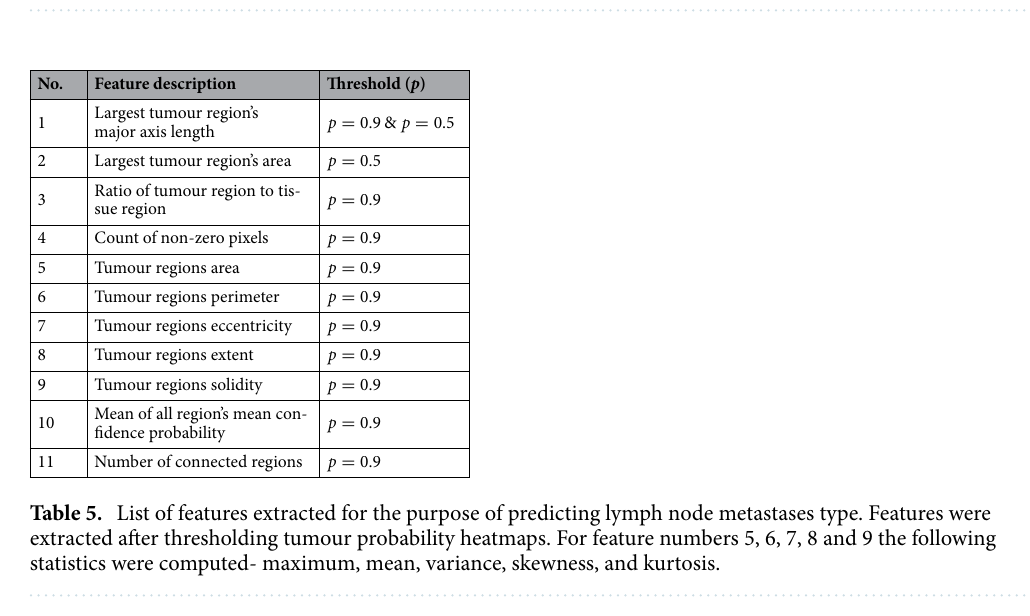
Figure 5. Overview of the steps involved in the pN-staging pipeline developed for CAMELYON17 dataset. Drawn using draw.io (draw.io).